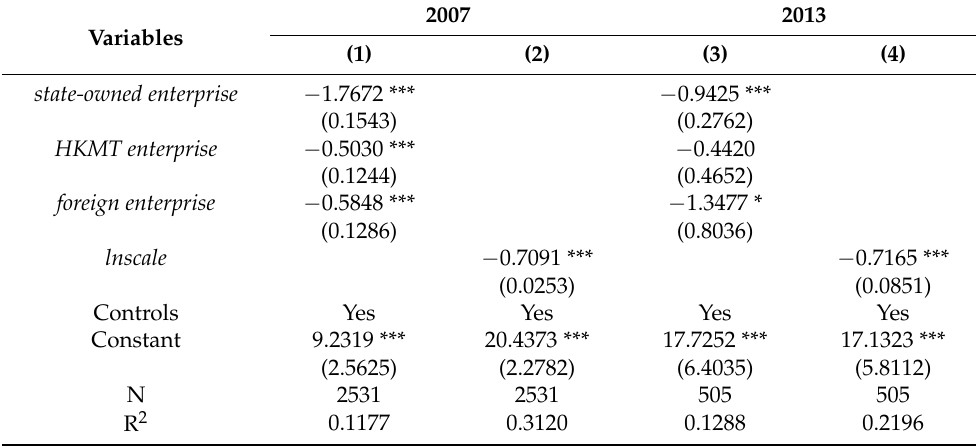
Table 9. Results of enterprises’ willingness to bid when industrial land is transferred through negotiation.